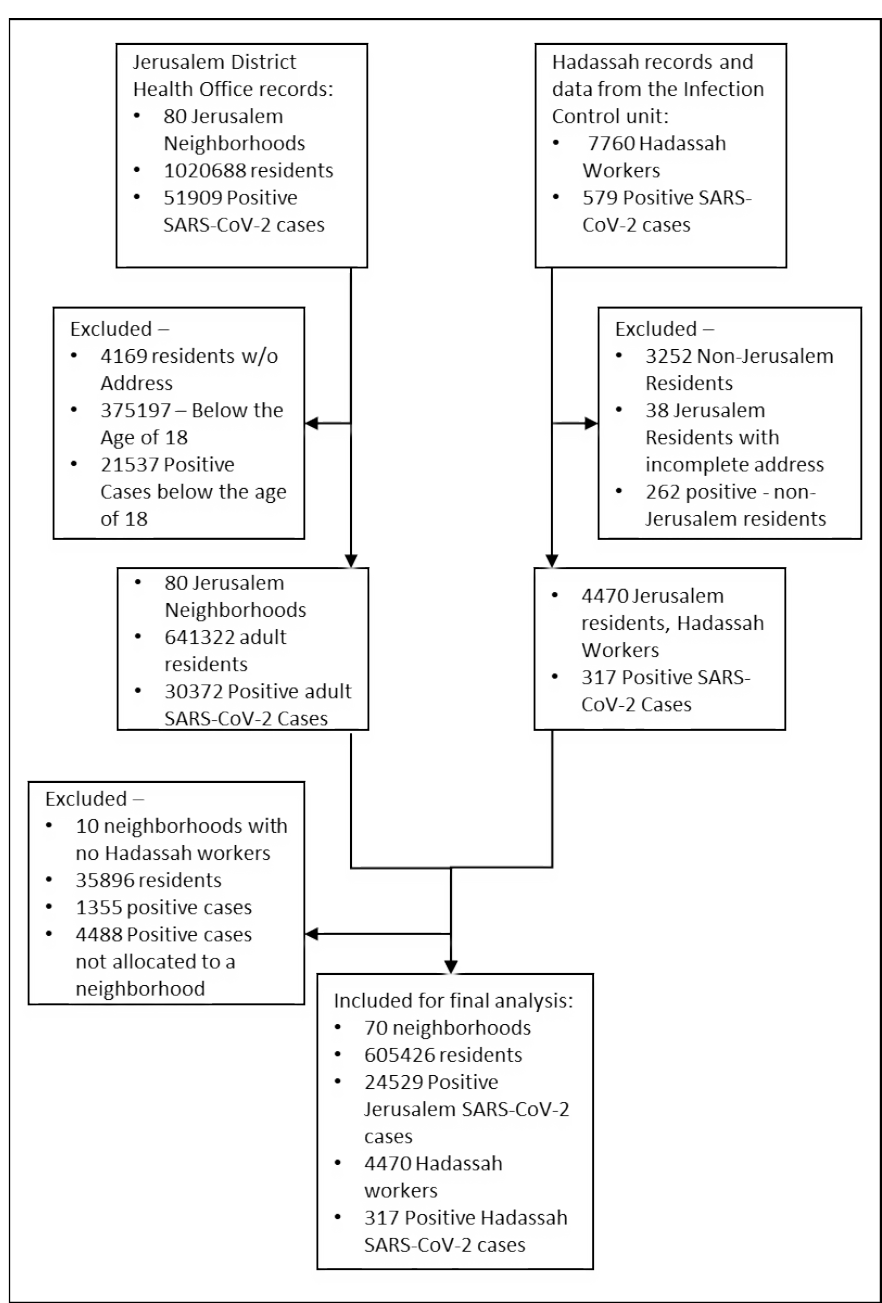
Figure 1. Flow diagram of study population inclusions and exclusions. Rate ratios and 95% confidence intervals of COVID-19 positivity for the hospital staff and the general population in each neighborhood were calculated using WinPepi version 11.65 (Brixton Health). A correction factor of 0.5 was added to the number of positive cases